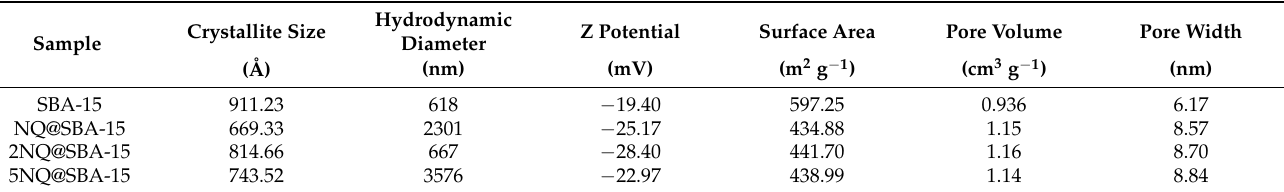
Table 1. Characteristics of the SBA-15 and systems NQ@SBA − 15, 2NQ@SBA − 15, and 5NQ@SBA − 15 obtained by X-ray diffraction (XRD), dynamic light scattering (DLS), z-potential measurements, and